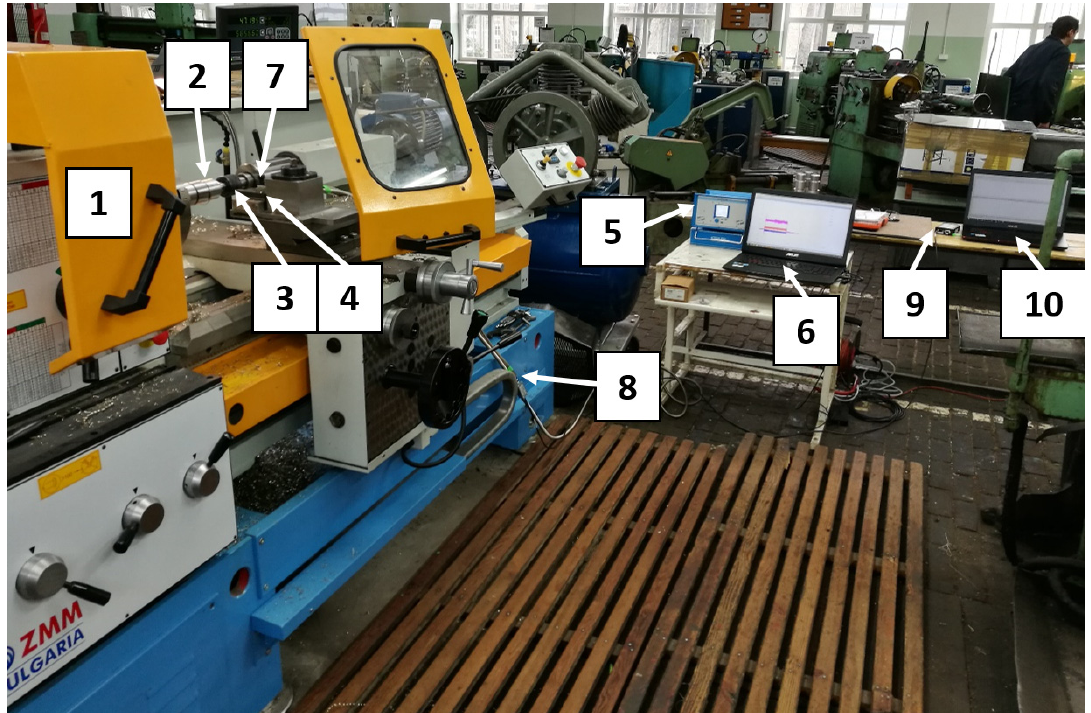
Figure 4. Laboratory stand: 1 – lathing machine, 2 – shaft, 3 – tool, 4 – dynamometer, 5 –